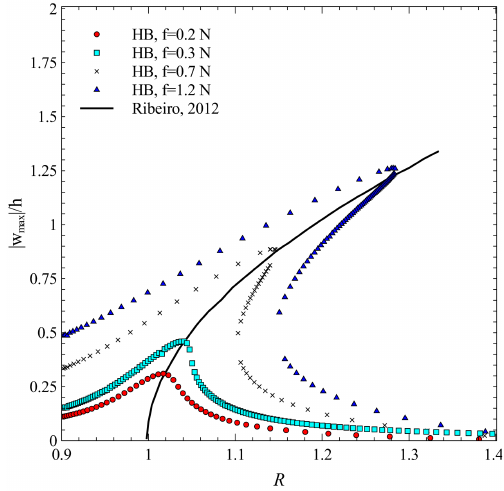
Figure 5. HB method–comparison with